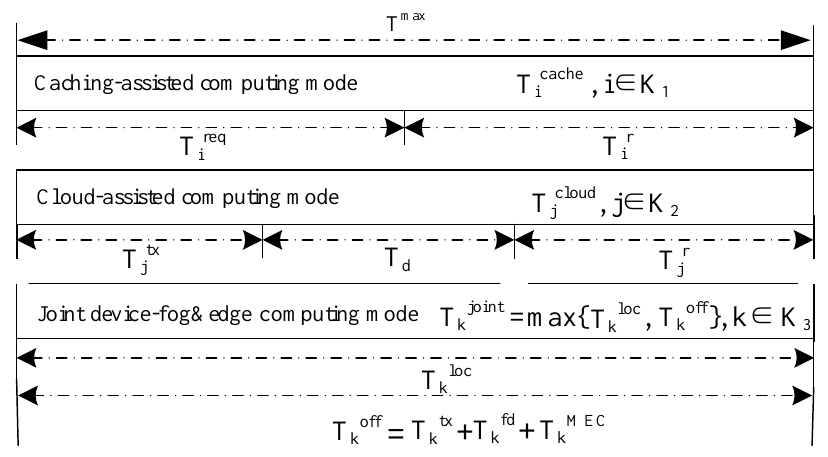
Figure 2. Illustration of the transmit protocol for a given time